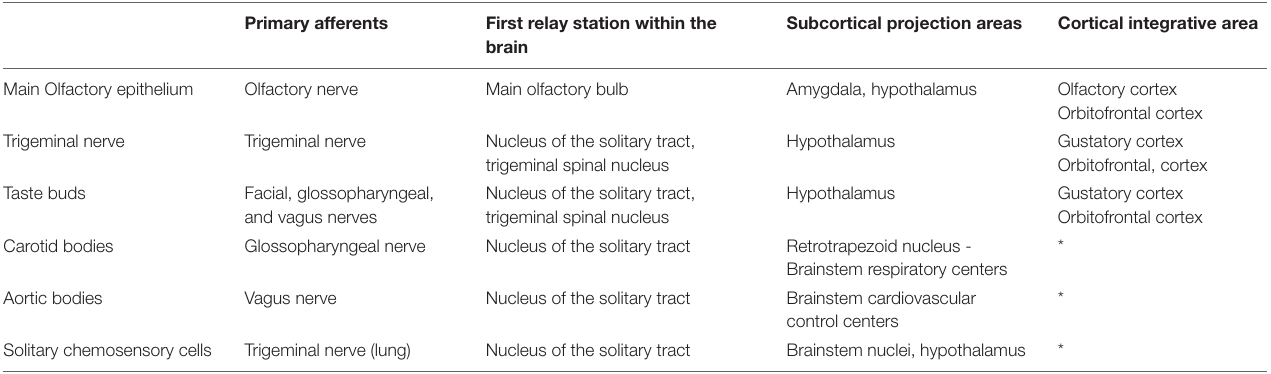
TABLE 2 | Summary of the main projection areas of the different peripheral chemosensory